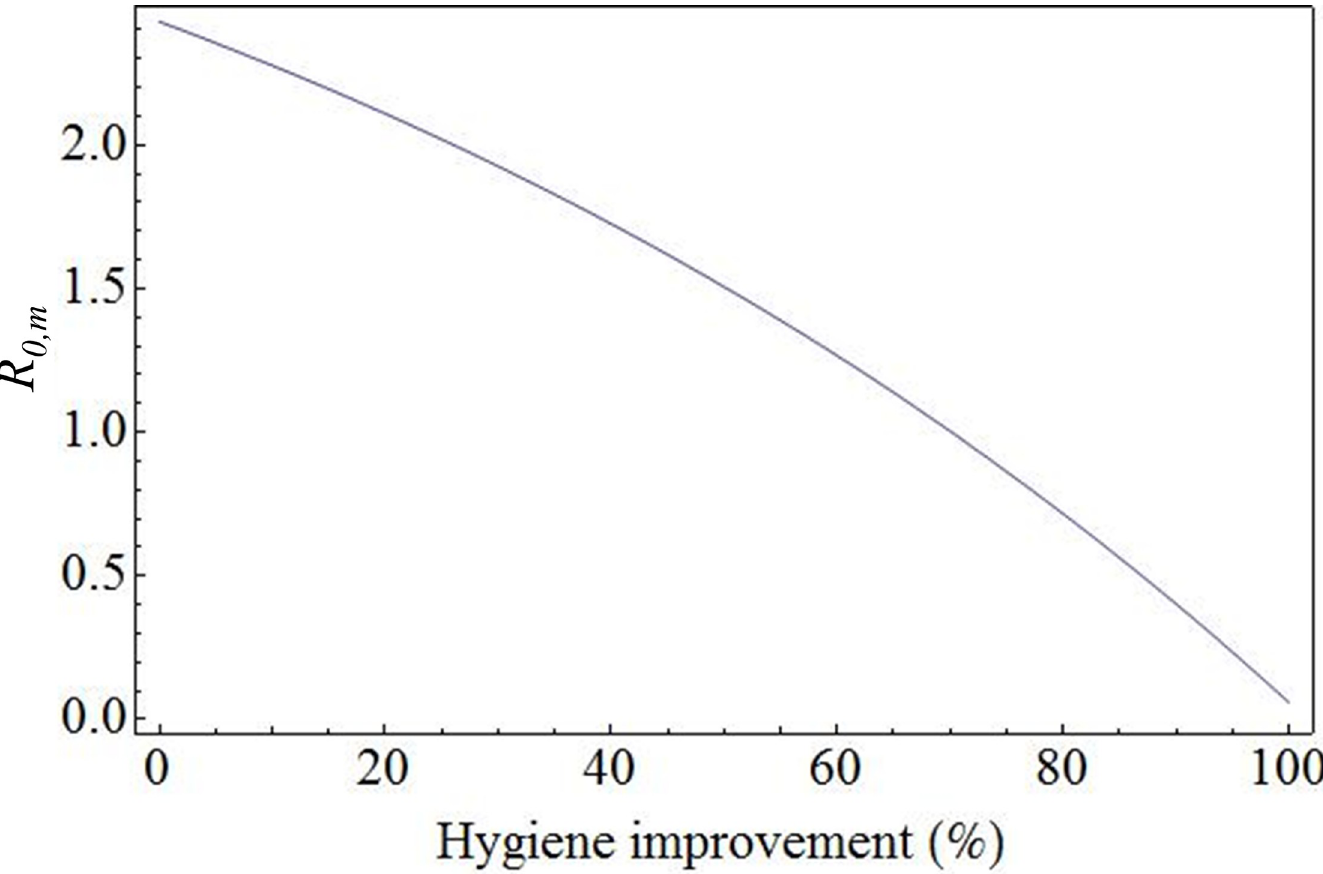
Fig 3. Reproduction number R 0, m of VPI compartment farms, when all transmission probabilities of the contact types of Table 1 are reduced with a certain percentage, due to improvement of biosecurity measures within the compartment. A biosecurity improvement of 0% represents the biosecurity status of poultry farms during the HPAI epidemic in the Netherlands in 2003. A biosecurity improvement of 100% is a purely fictitious scenario of perfect biosecurity leading to zero